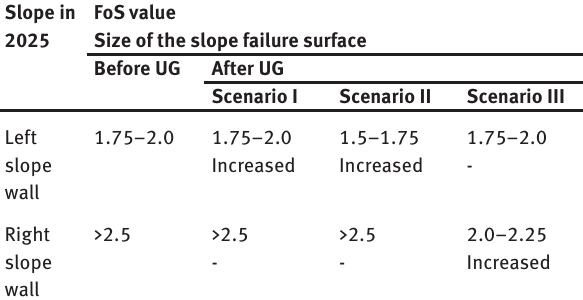
Table 4: Change of FoS value and size of the slope failure surface with different scenarios of UG operation by